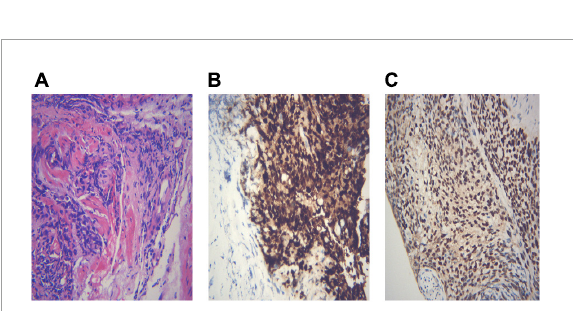
FIGURE4 Images from different cancer types. According to the morphological characteristics of cells, ROSE can achieve accurate classification of lung cancer subtypes. (A) Squamous cell carcinoma, 400 × ; (B) adenocarcinoma derived from gastrointestinal cancer metastasis, 400 × ; (C,D) adenocarcinoma, 400 × .